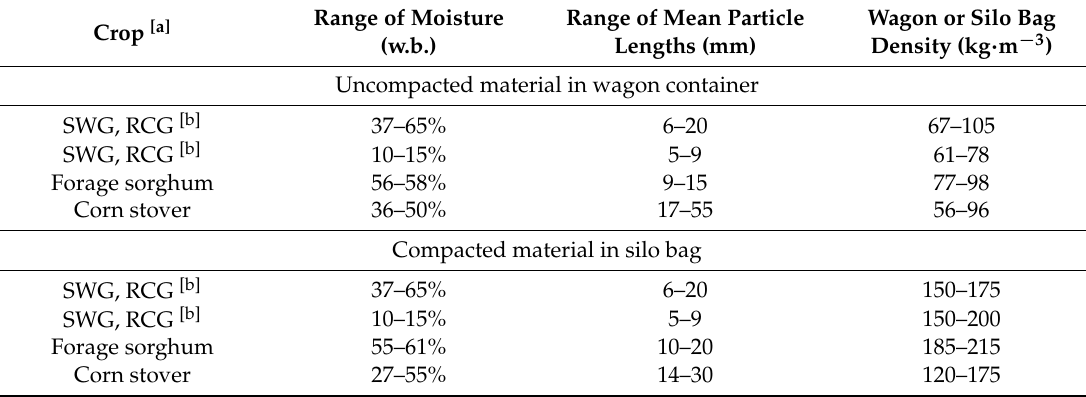
Table 8. Range of densities (dry basis) of chopped biomass material either uncompacted in the wagon container or after compaction in a silo